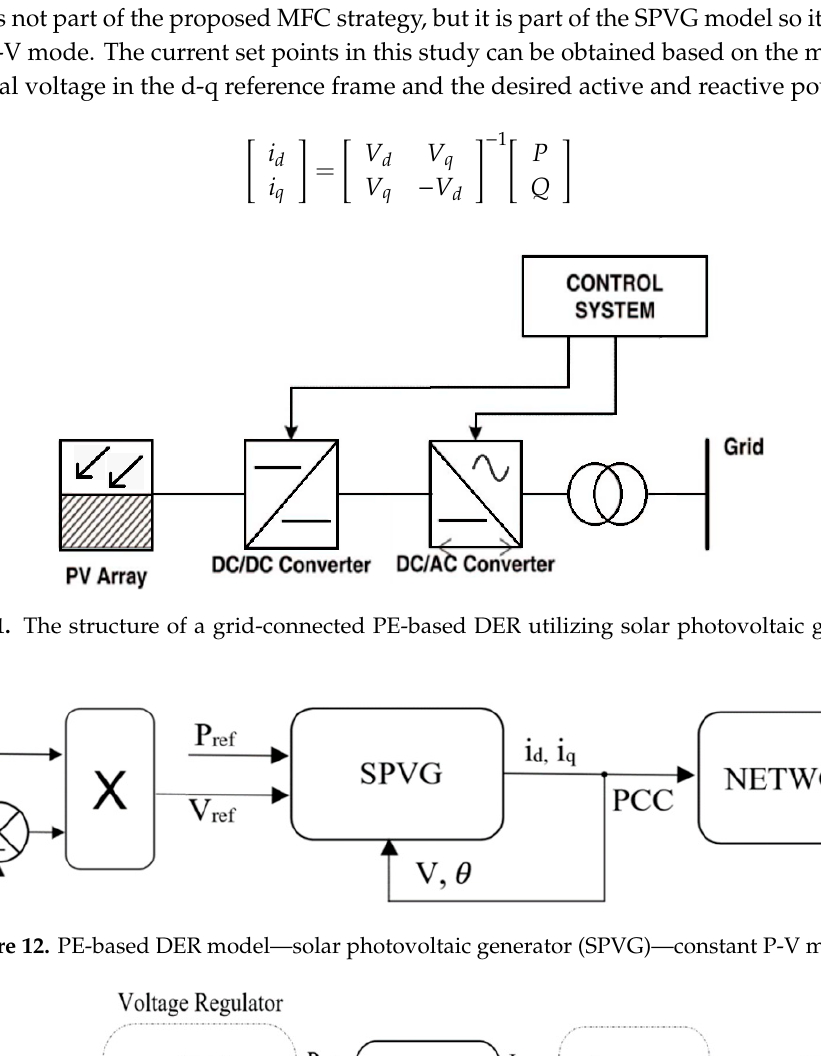
Figure 11. The structure of a grid-connected PE-based DER utilizing solar photovoltaic generator (SPVG).